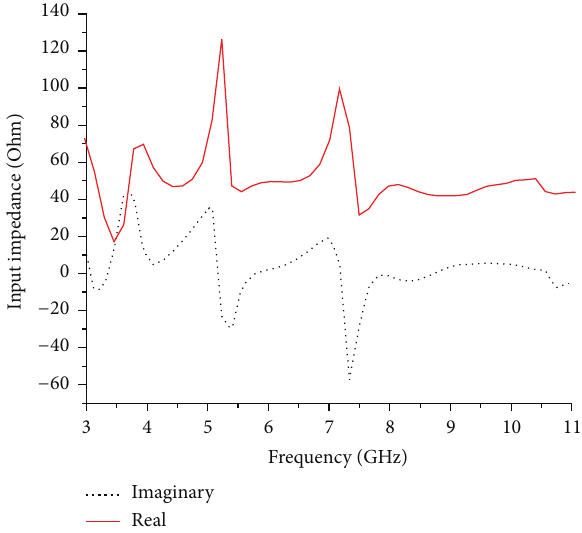
Figure 9: Real and imaginary part of the input impedance of the proposed